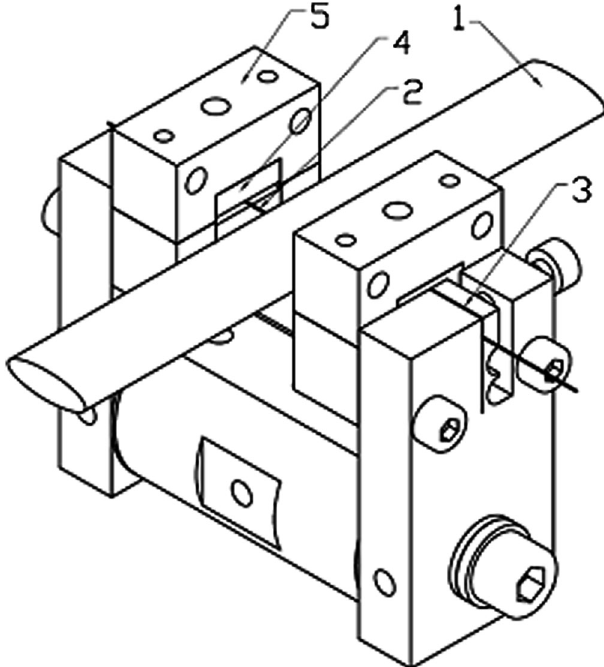
FIG. 1. The main view of the original design of the VWM. 1: beam; 2: vibrating wire; 3: clips; 4: magnet; 5: magnet holder. Here, the vibrating wire serves as a target for the beam at the same time. The wire length is 36 mm, but only ∼ 1 = 3 of the wire is available as a target for the beam